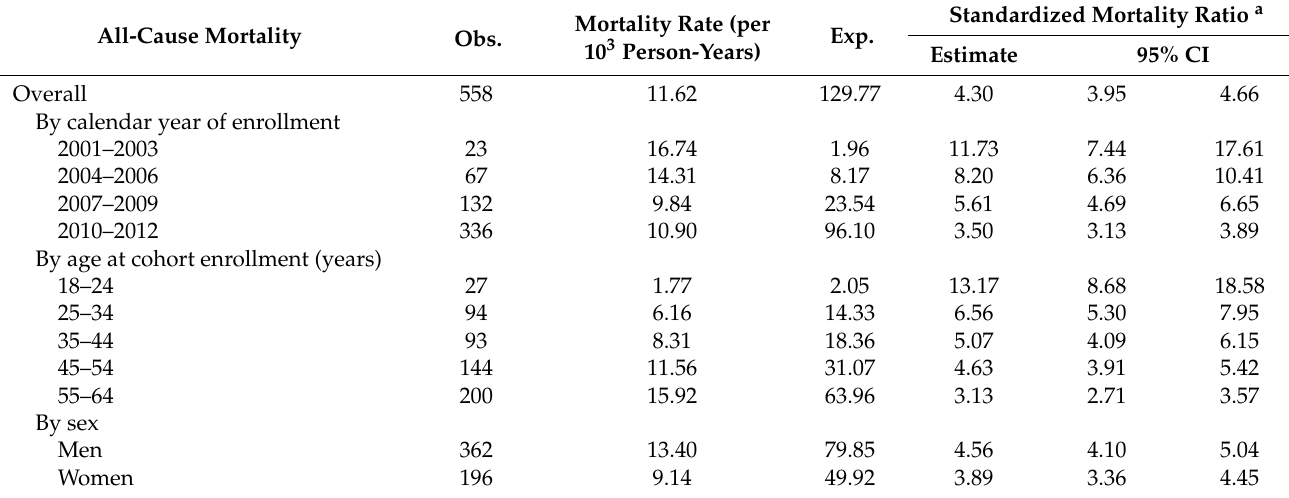
Table 2. All-cause standardized mortality ratios among individuals without cancer who were long-term users of opioid analgesics. Mortality Rate (per All-Cause Mortality Obs. 10 3 Person-Years)